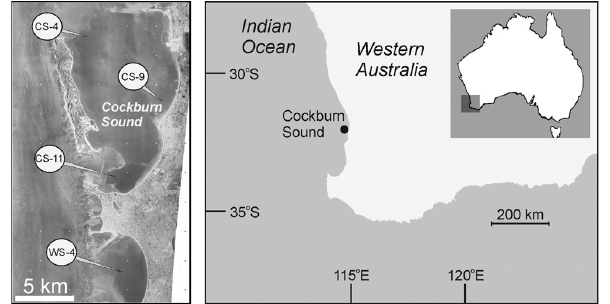
Fig. 2. Left: Long-term monitoring sites in Cockburn and Warn- bro Sounds. Right: Location of the Cockburn Sound study area in southwestern